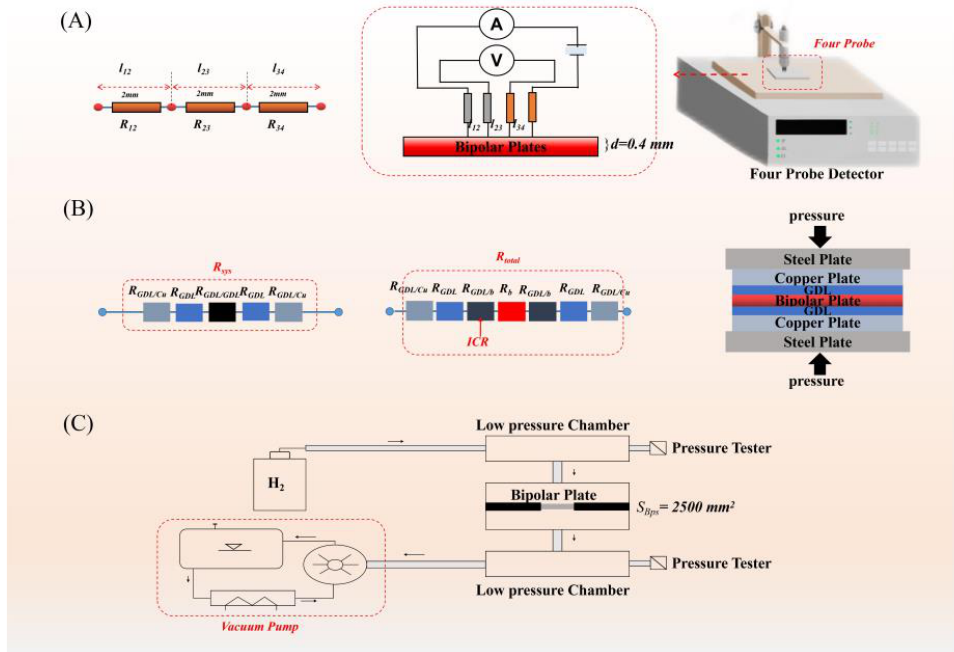
Figure 2. ( A ) Four-probe equipment and schematic diagram; ( B ) ICR testing equipment and sche- matic diagram; ( C ) hydrogen permeability testing equipment.